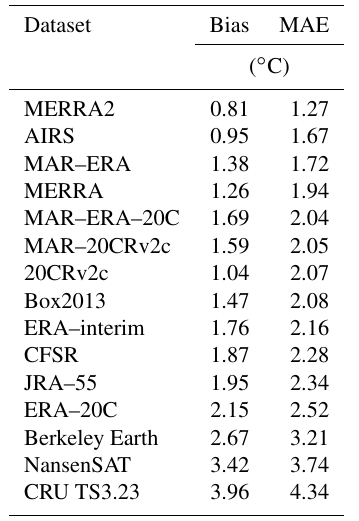
Table 3. Mean bias and mean absolute error (MAE) for all datasets ranked from smallest (top) to largest (bottom) MAE. These numbers represent an average of results from Figs. 3 and 4, with unweighted average over months and an area-weighted average over glaciologi- cal regimes (64.9% ice sheet above 1500m, 18.6% ice sheet below 1500m and 16.5% coastal